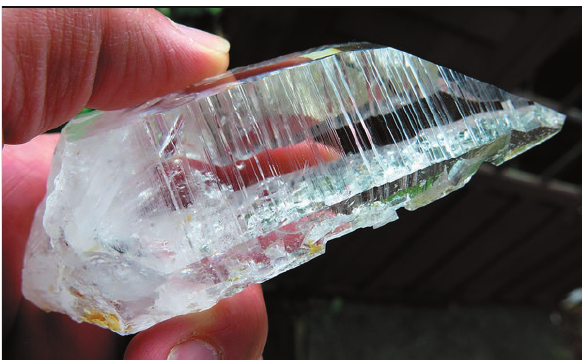
Fig. 8. Quartz crystal with striated faces (https://goldenhourminer- als.com/listing/864704147/cristallo-naturale-colombiano-di-quarzo).